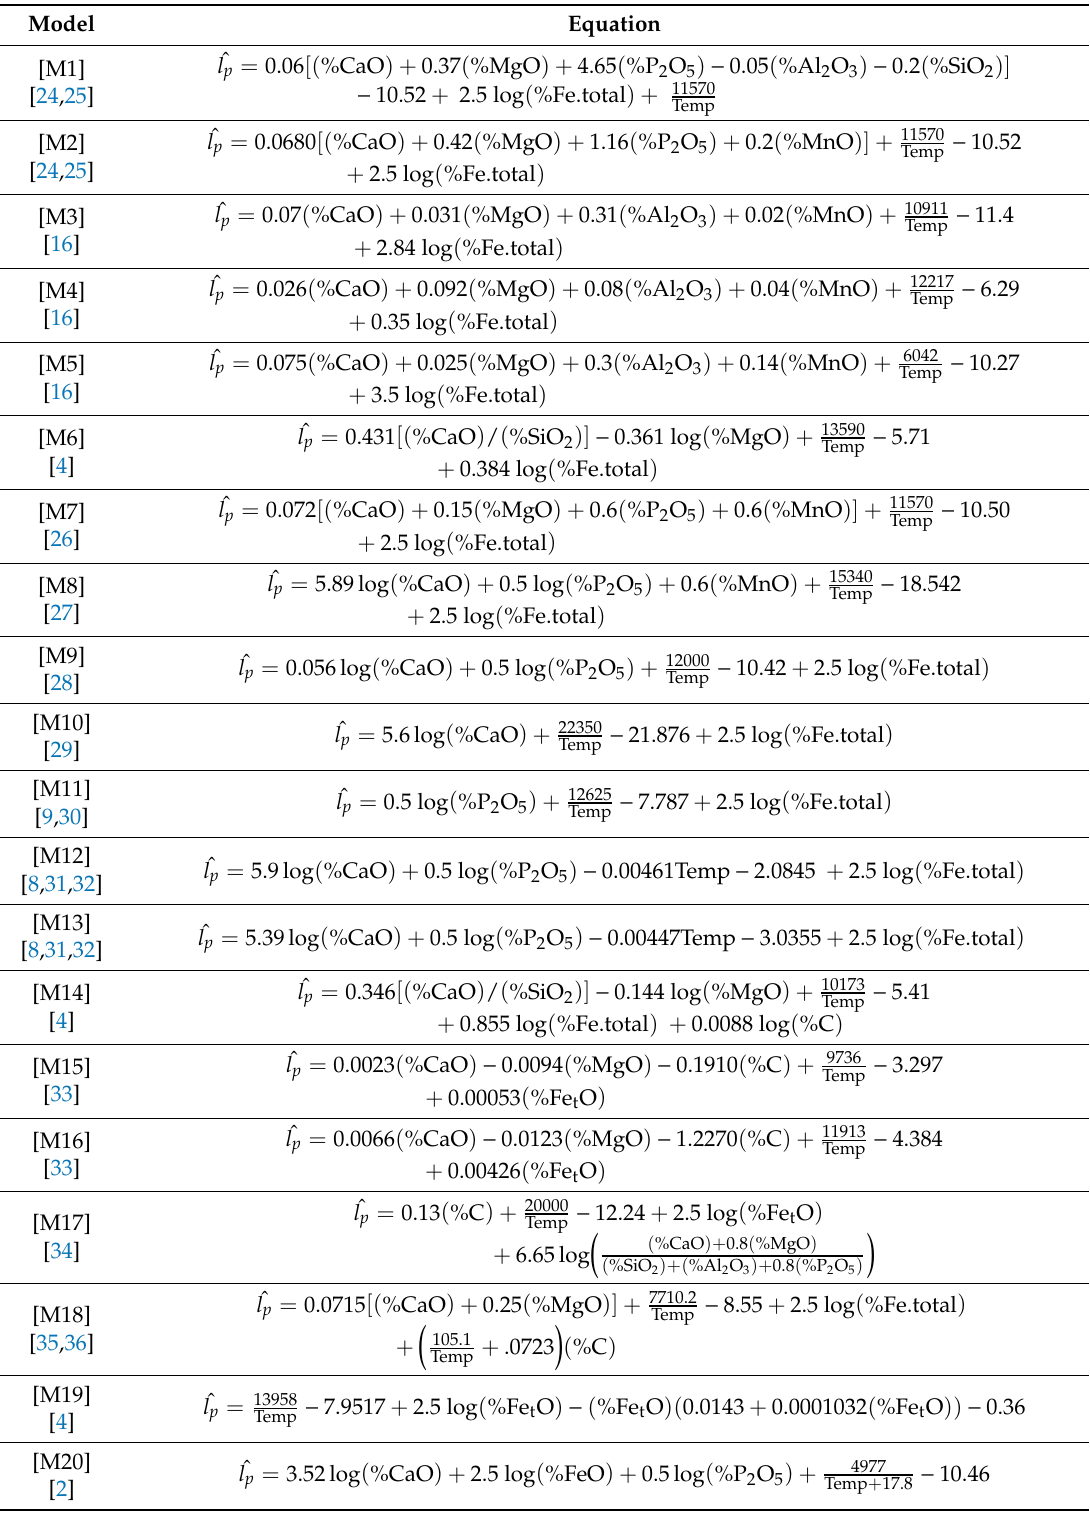
Table 6. List of existing candidate model to predict dephosphorization in steel.